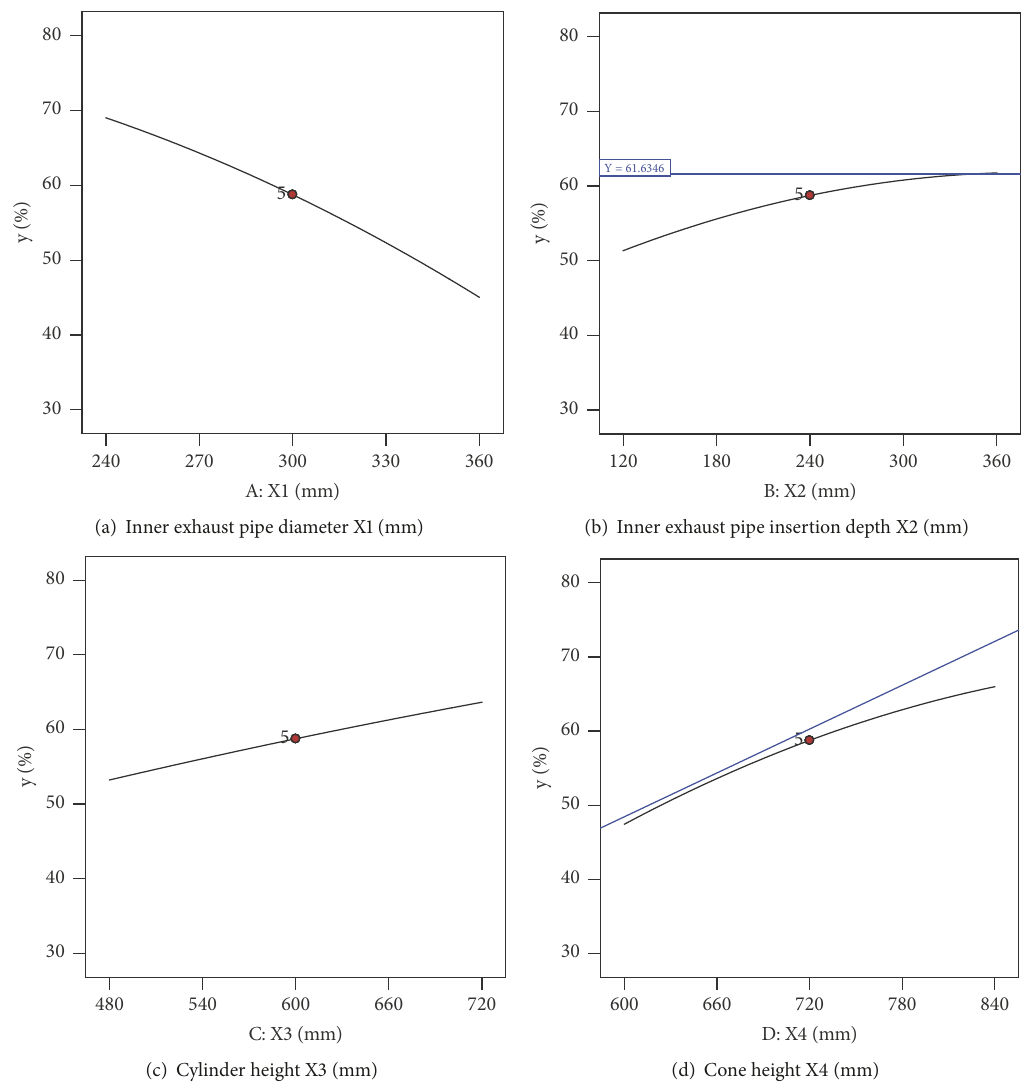
Figure 6: Effect of a single factor on